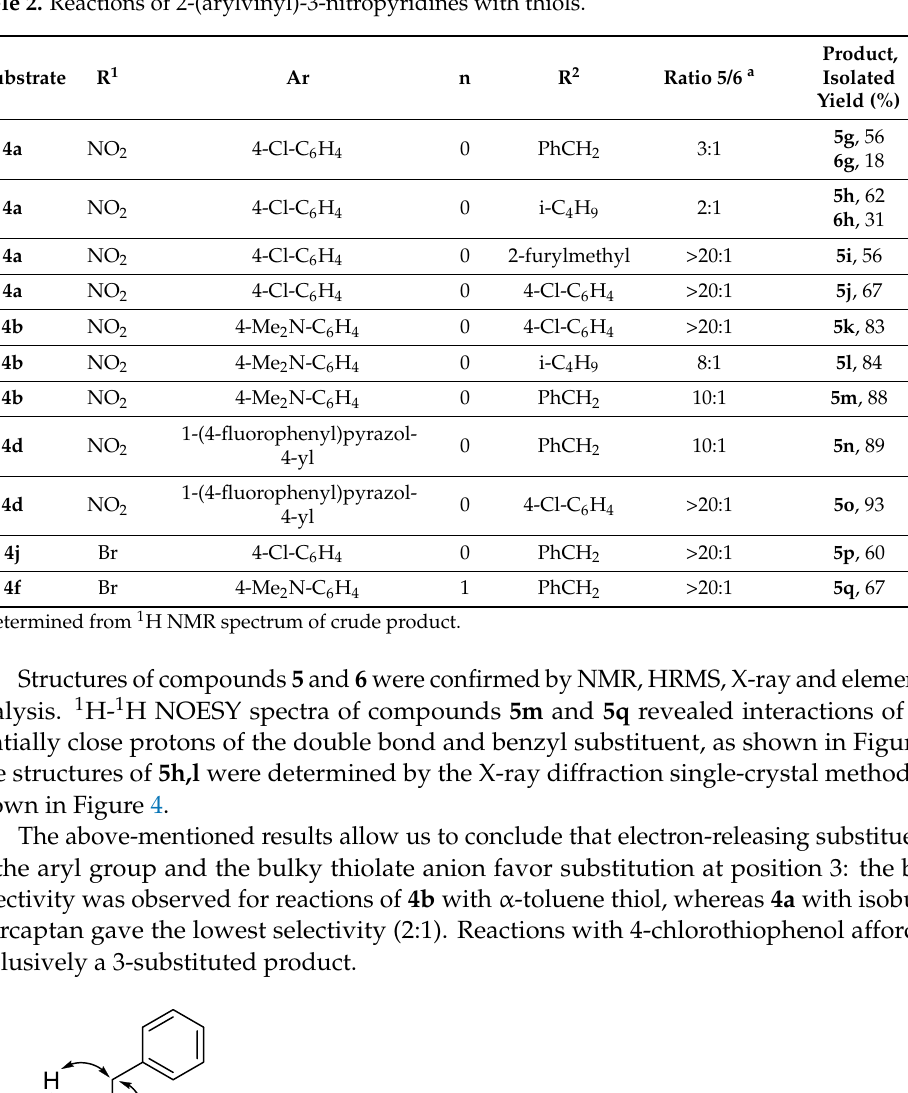
Figure 3. Cross-peaks observed in 1 Н - 1 Н NOESY spectrum of compounds 5m (R 1 = NO 2 ) and 5q (R 1 = Br).